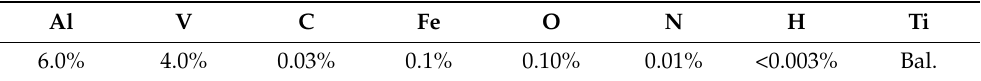
Table 1. Nominal chemical specification of powders distributed by Arcam AB [34].